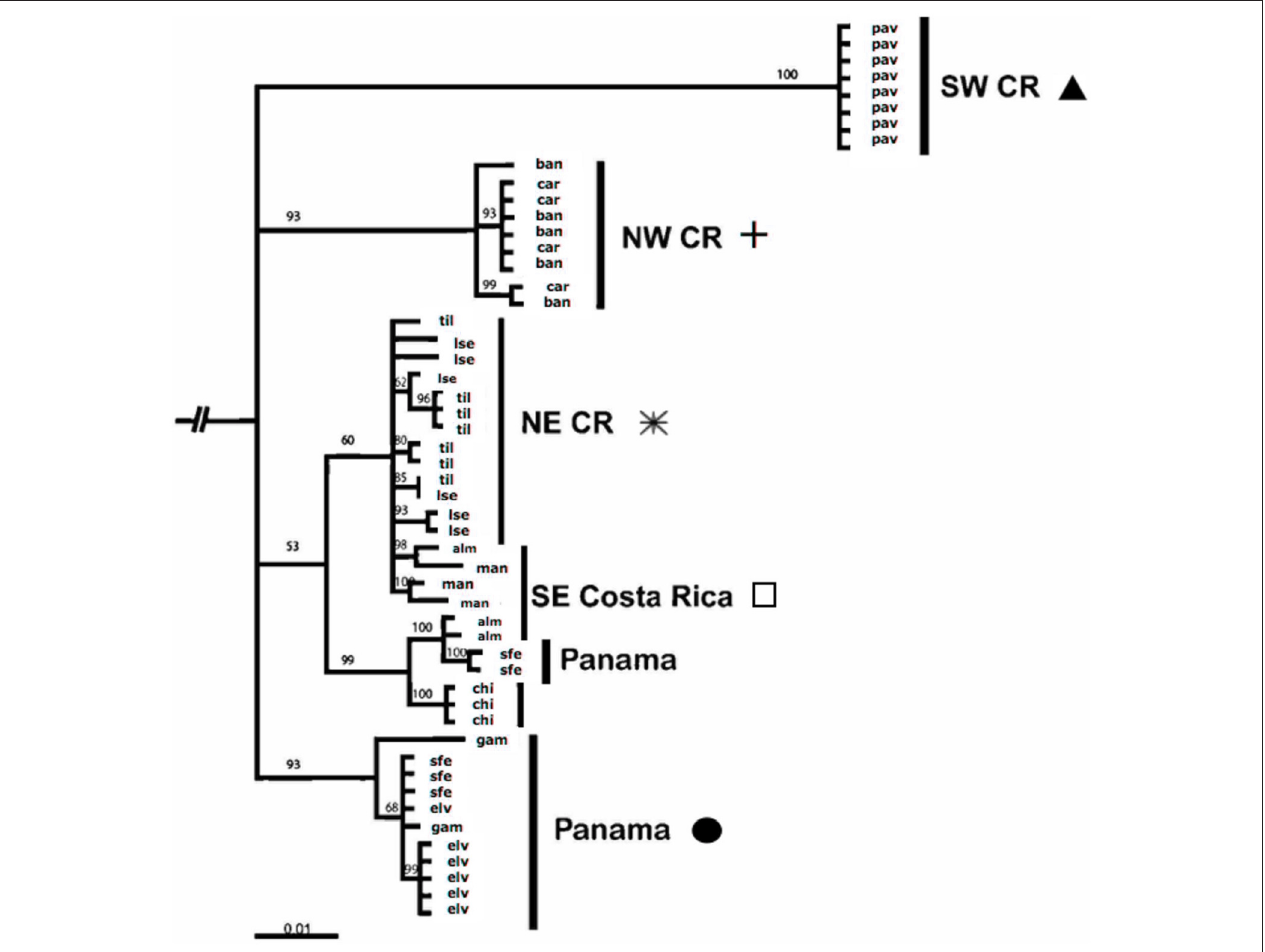
FIGURE 4 | Bayesian consensus phylogram for mitochondrial ND1 gene for 53 A. callidryas throughout their range in Costa Rica and Panama and the outgroup, A. saltator